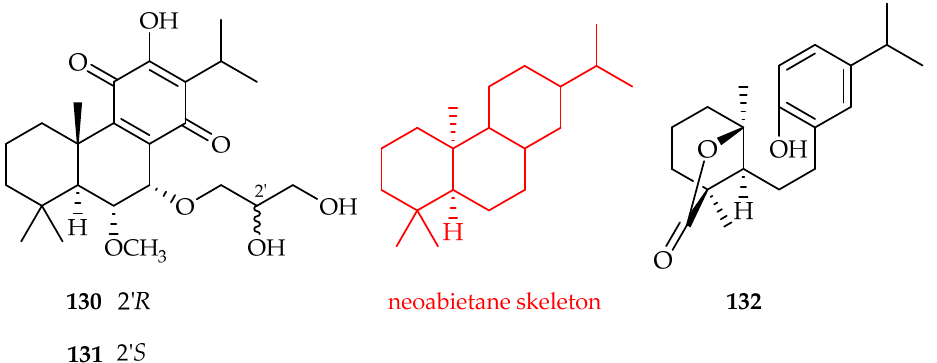
Figure 54. Structures of salvidesertone E 130 [82], salvidesertone F 131 [82], and kunminolide A 132 [83].